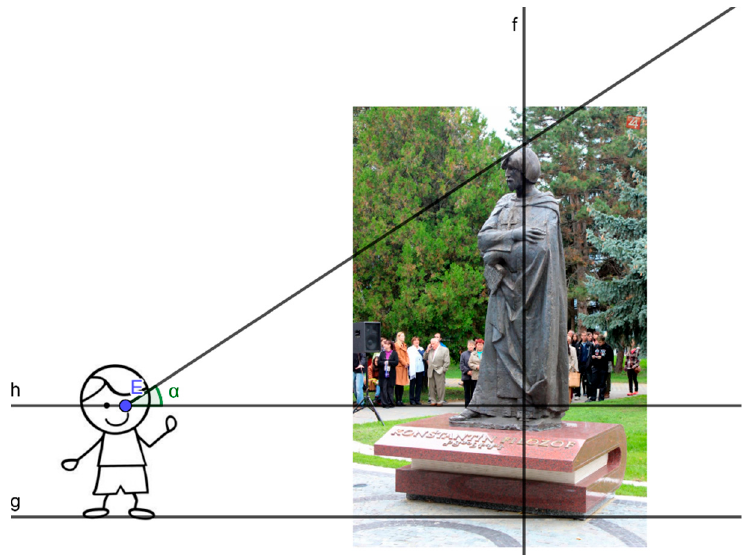
Figure 3. The sketch used to calculate the height of the statue based on the view angle.